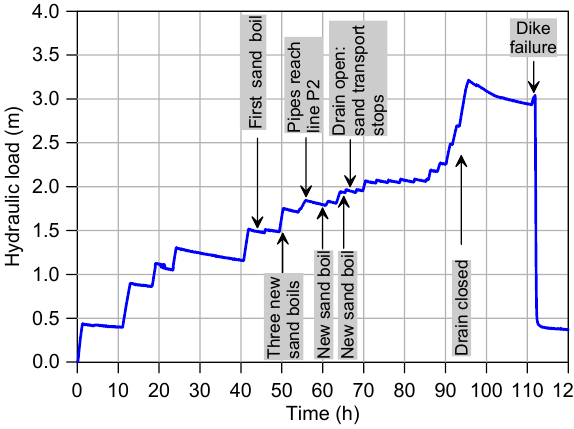
Figure 5. Hydraulic load applied to the test